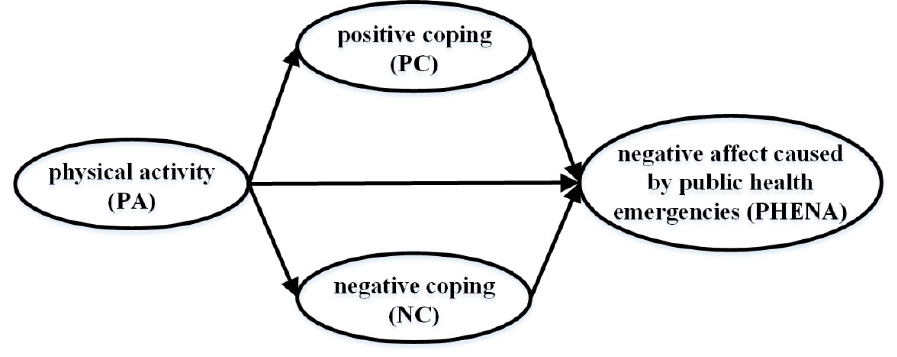
Figure 1. Hypothetical model.